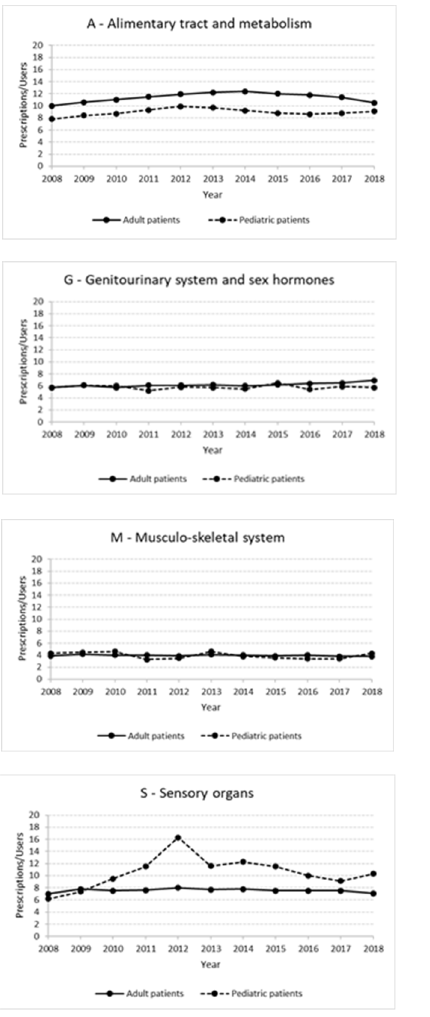
Figure 4. Graphs showing the intensity of use (expressed by the ratio prescriptions/users) for each therapeutic category in adult and pediatric RD patients in the period 2008–2018.